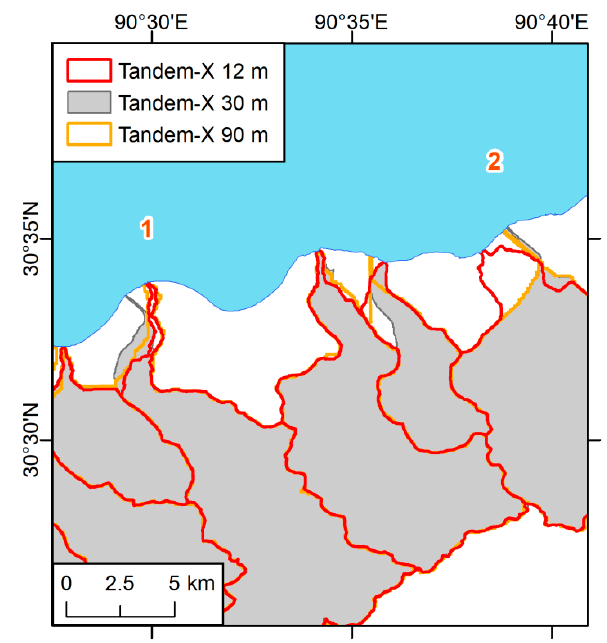
Figure 9. Two subcatchments and outlets where TDX12 (red), TDX30 (gray), and TDX90 (orange) outlets largely differ (©DLR 2017 & 2018) as a result of different postings from resampling the same underlying dataset.